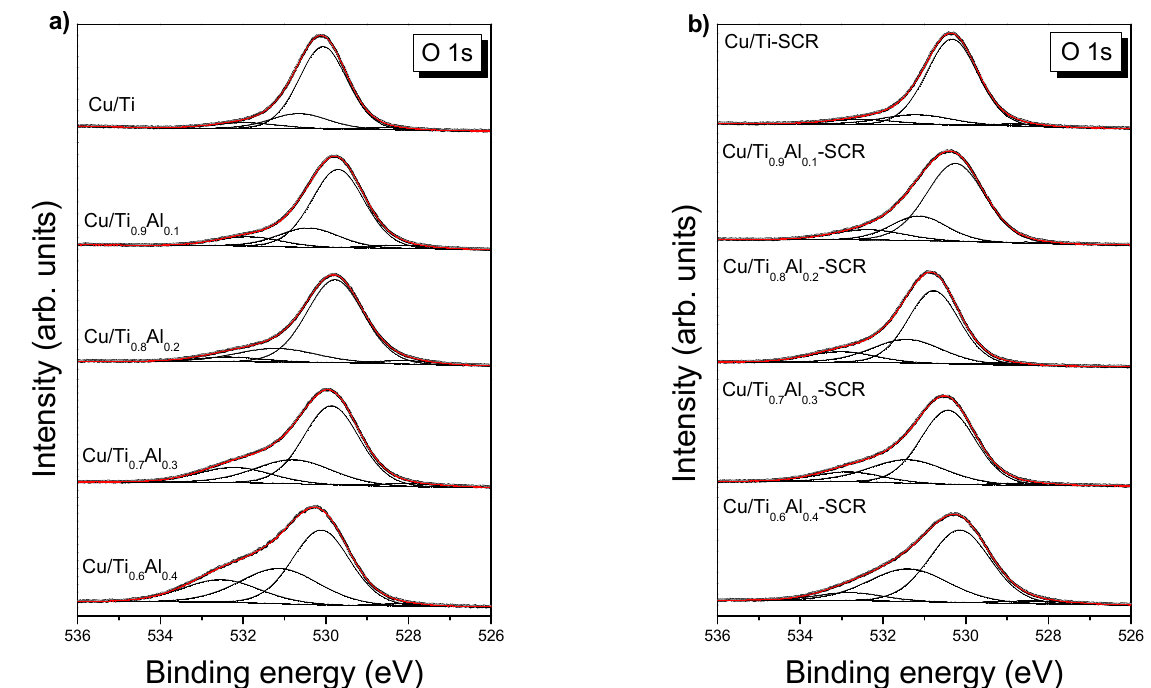
Figure 5. O 1s XPS spectra of fresh ( a ) and used ( b ) catalysts.